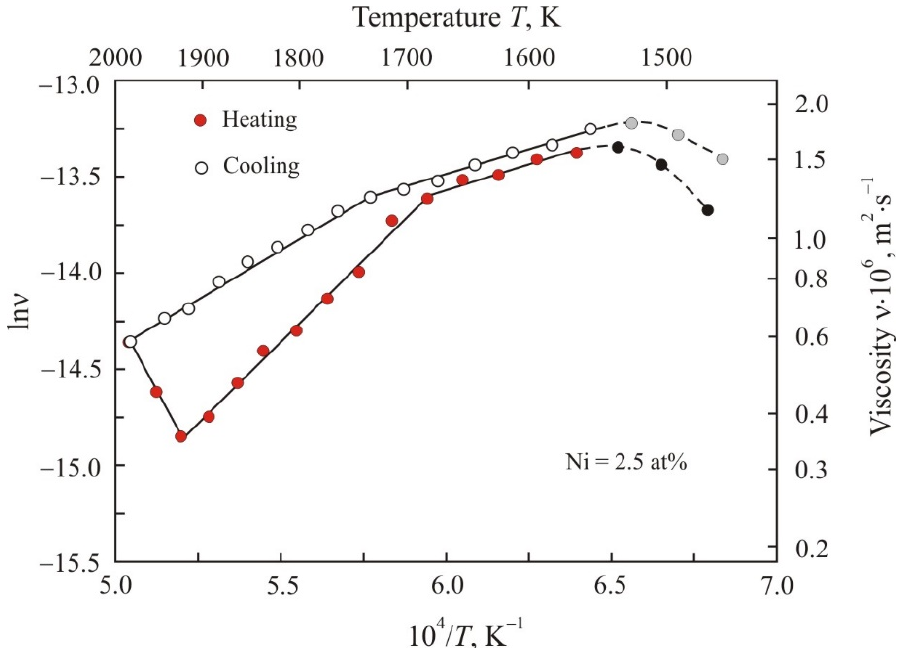
Figure 1. Kinematic viscosity on a natural logarithmic scale ln ν as a function of the inverse absolute temperature T − 1 upon heating to maximum temperature T max = 1985 K and cooling the Fe 72.5 − x Ni x Cu 1 Nb 2 Mo 1.5 Si 14 B 9 alloys with Ni content 2.5 at. %.